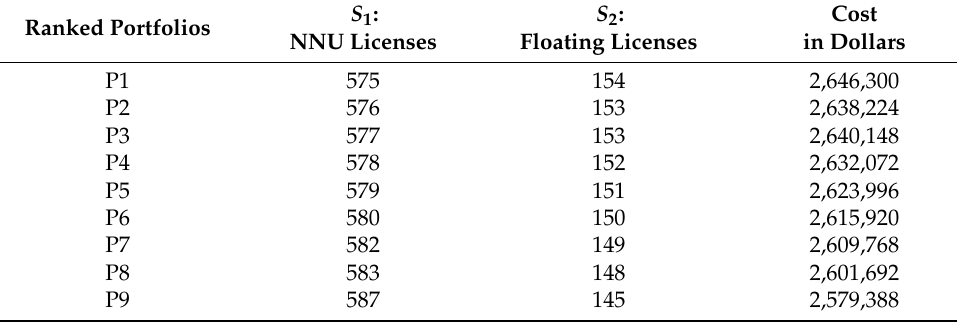
Table 3. Top nine portfolios in the baseline